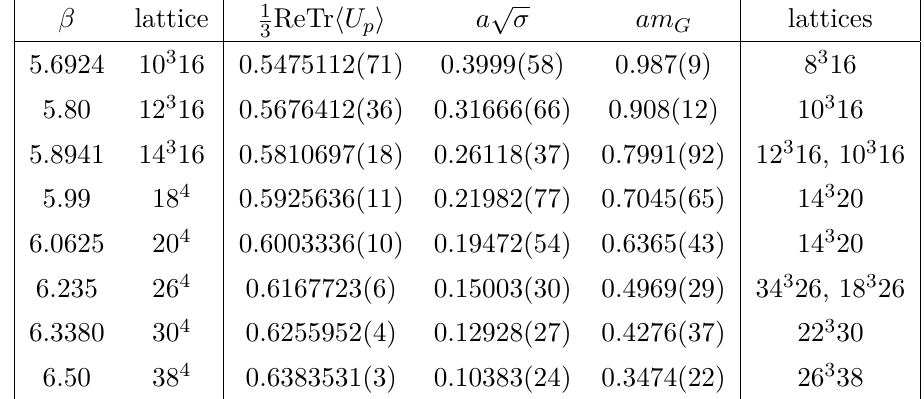
Table 1 . Parameters of the SU(3) calculations as well as the string tension, σ , and the mass gap, m G . On the right are shown other lattice sizes used for finite volume studies and for calculations of the topological charge.